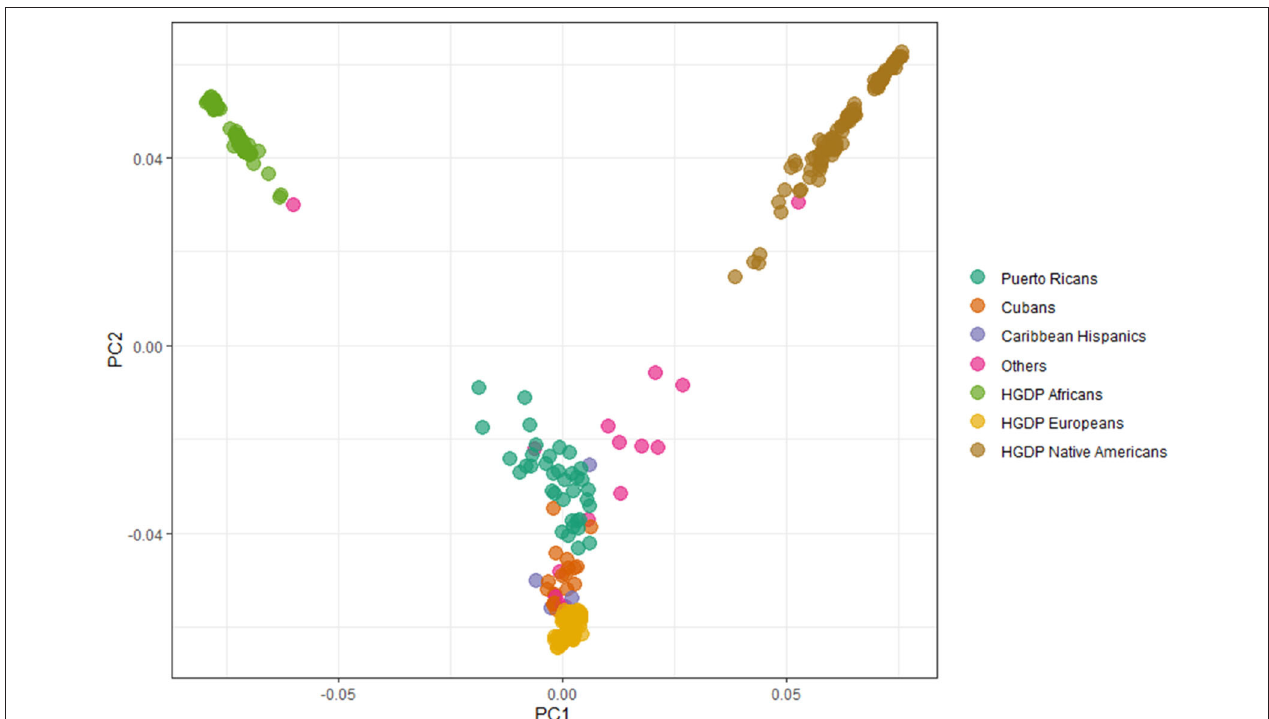
FIGURE 1 | Principal component analyses. Estimation of relationship to ancestral groups from Human Genome Diversity Project (HGDP). Aqua = Puerto Ricans. Orange = Cubans. Purple = Caribbean Latinos (including Dominican Republic, mixed or undefined Caribbean origin). HGDP datasets included Europeans (yellow), Africans (green), and Amerindians (brown).